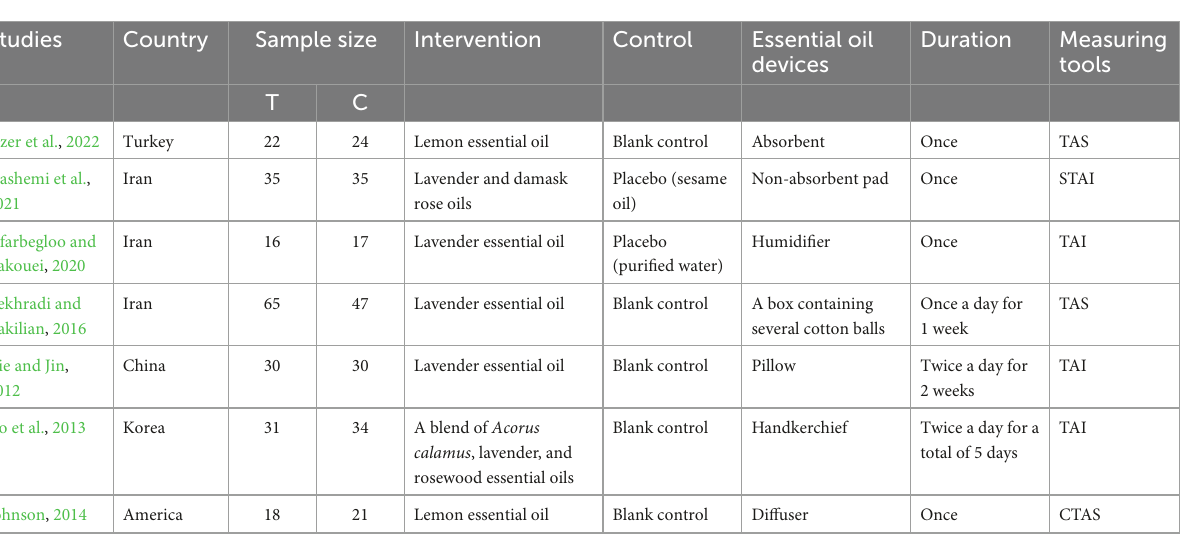
TABLE 1 Characteristics of the studies included in the